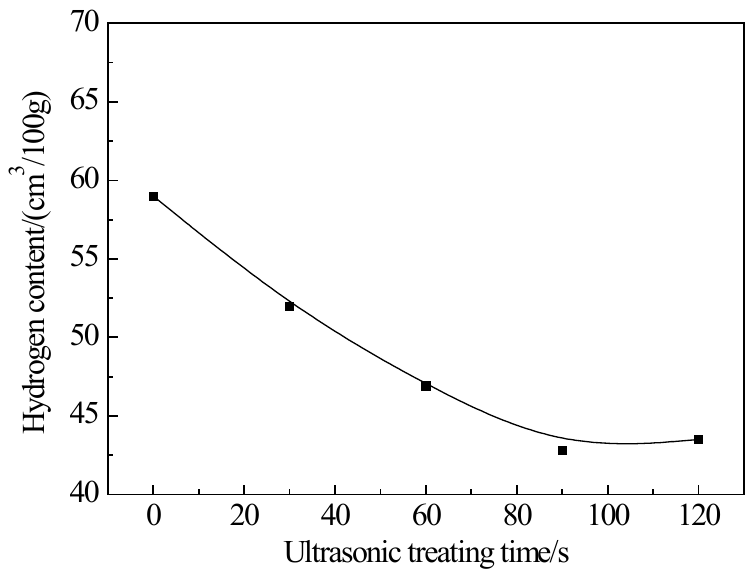
Figure 2. Effect of ultrasonic treating duration on hydrogen content of Mg-3.03Ca alloy.